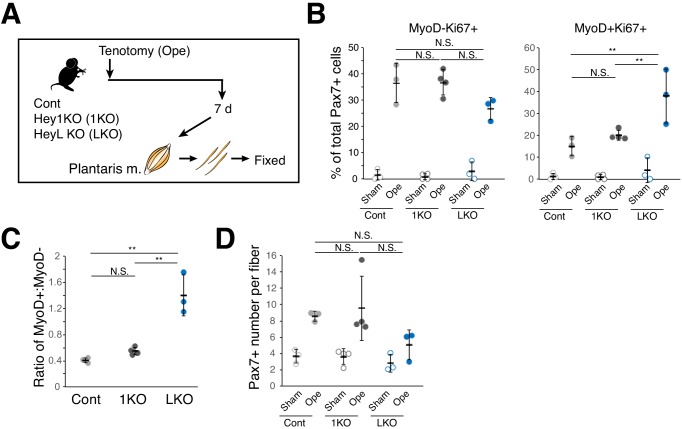
Increased ratio of MyoD-expressing myogenic cells and decreased cell number in overloaded HeyL-KO mice at 7 days after tenotomy.(A) Experimental scheme for analyzing Pax7+ cells on plantaris myofibers derived from control (Cont), Hey1-KO (1KO), or HeyL-KO (LKO) mice at 7 days after tenotomy (Ope) or derived from corresponding contralateral control muscles (Sham). (B) Frequency of MyoD−Ki67+ (left) or MyoD+Ki67+ (right) cells among Pax7+ cells on myofibers: sham (open circle) versus 7 days after tenotomy (closed circle) and derived from Cont (light gray, n = 3), 1KO (black, n = 4), or LKO (blue, n = 3) mice. **p<0.01. N.S.: not significant. (C) Ratio of MyoD+ to MyoD− cells among Ki67+Pax7+ cells on myofibers at 7 days after tenotomy and derived from Cont (light gray, n = 3), 1KO (black, n = 4), or LKO (blue, n = 3) mice. **p<0.01. N.S.: not significant. (D) Number of Pax7+ cells on myofibers: sham (open circle) versus 7 days after tenotomy (closed circle) and derived from Cont (light gray, n = 3), 1KO (black, n = 4), or LKO (blue, n = 3) mice. N.S.: not significant. Data represent the mean ± standard deviation. One-way ANOVA, followed by the Tukey–Kramer test, was used for statistical analyses.10.7554/eLife.48284.011Figure 4—figure supplement 1—source data 1.Numerical data for making the graphs in Figure 4—figure supplement 1.Experiment number corresponds to all results.